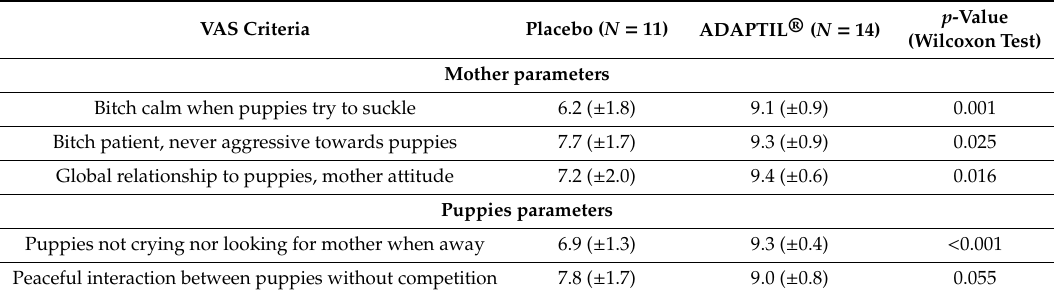
Table 8. Distribution of the visual analogue scale (VAS) scores according to treatment, all times combined ( N = 25). Mean values out of a total of 10 + standard